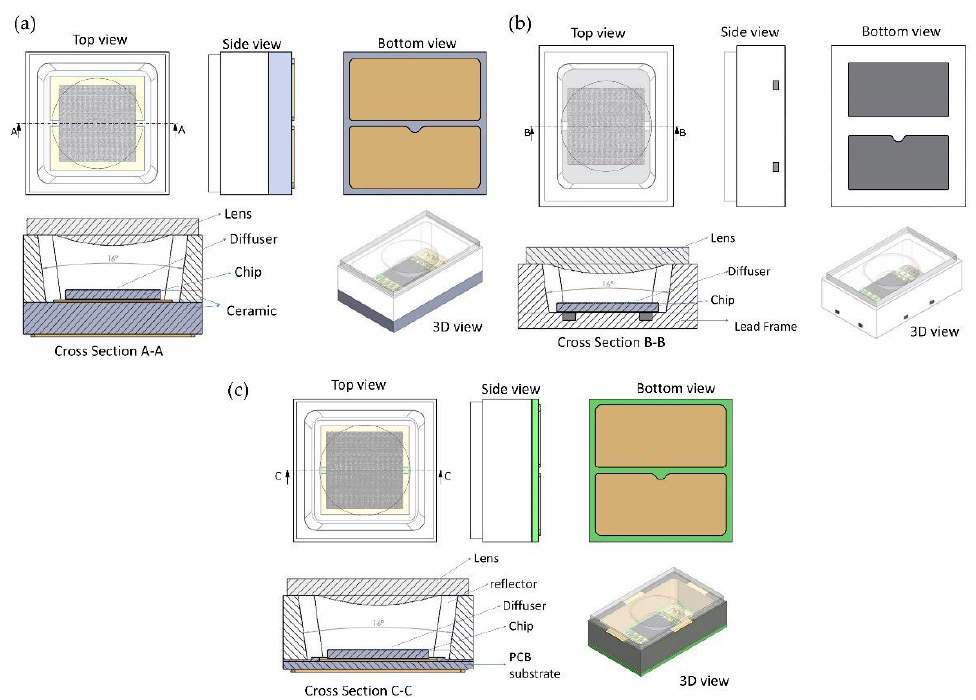
Figure 5. Three types of VCSEL packages are proposed, which incorporate all of the key components attached to the package, including the diffuser on top of the chip: ( a ) ceramic, ( b ) lead frame, and ( c ) PCB.